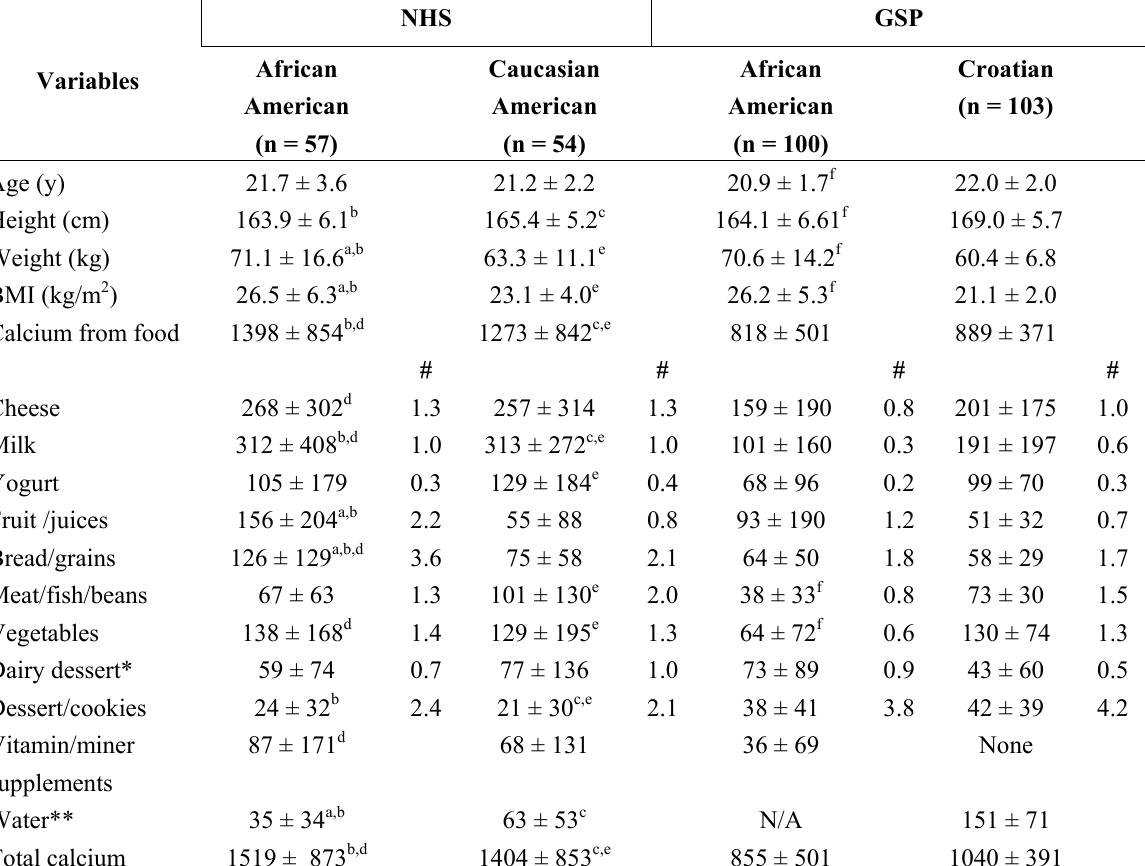
Table 1. Descriptive characteristics (Mean ± SD), calcium intake (mg/day), servings per day and sources of dietary calcium among the Nutrition-Health Students (NHS) and General-Student Populations